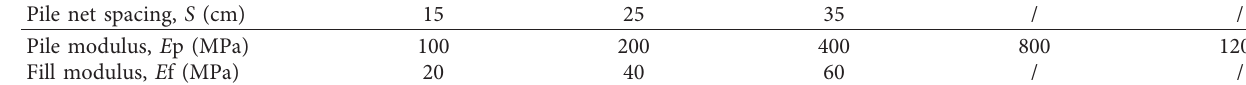
Table 4: Details of influence factors.